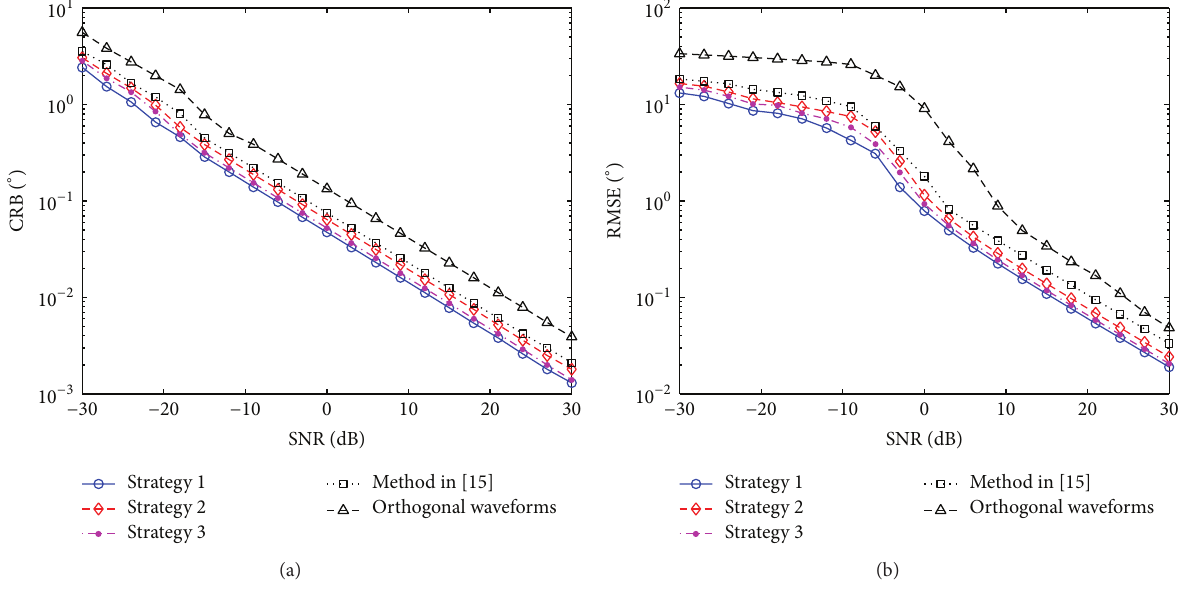
Figure 5: (a) CRB versus SNR in Example 2. (b) RMSE versus SNR in Example 2.